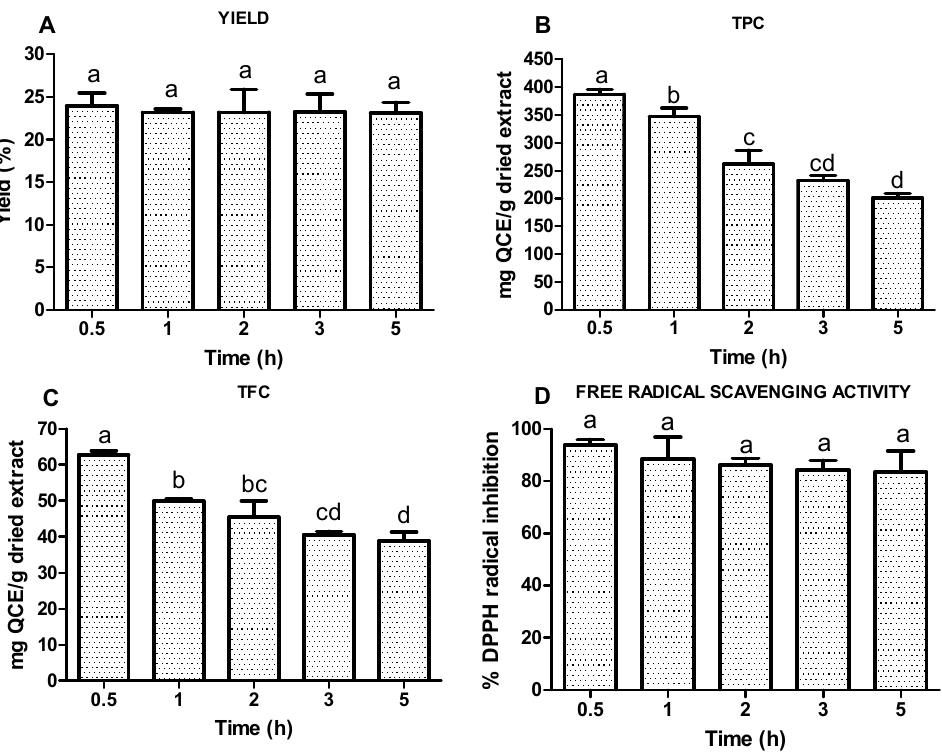
Figure 4. E ff ect of contact time on the extraction % yield ( A ), TPC ( B ), TFC ( C ), and DPPH free radical scavenging activity ( D ) from OPLs. Di ff erent letters indicate significant di ff erence between tested parameters ( p <